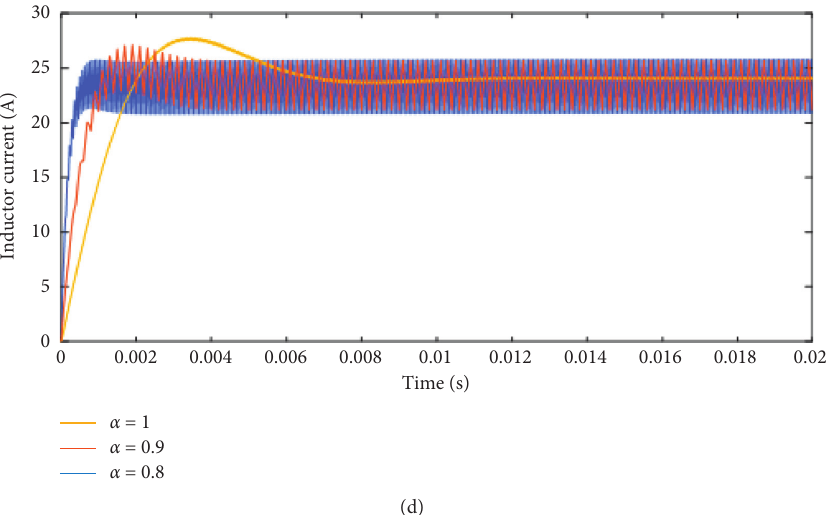
Figure 6: Simulation results of fractional-order model of equivalent DC-DC converter: (a) output voltage of fractional-order model of equivalent Buck converter; (b) inductor current of fractional-order model of equivalent Buck converter; (c) output voltage of fractional- order model of equivalent Boost converter; (d) inductor current of fractional-order model of equivalent Boost